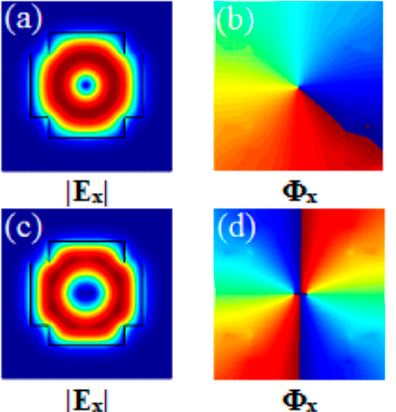
Figure 4. Field (Ex, horizontal component) and phase distributions of the OAM modes with the designed component guided modes: ( a ) electric field and ( b ) phase distributions for the l = ±1 OAM mode; and ( c ) the electric field and ( d ) phase distributions for l = ±2.